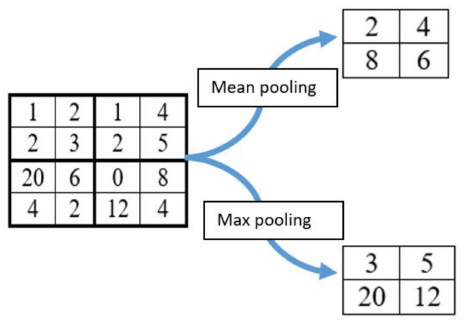
Figure 3. Illustration of the two pooling methods: Mean and Max